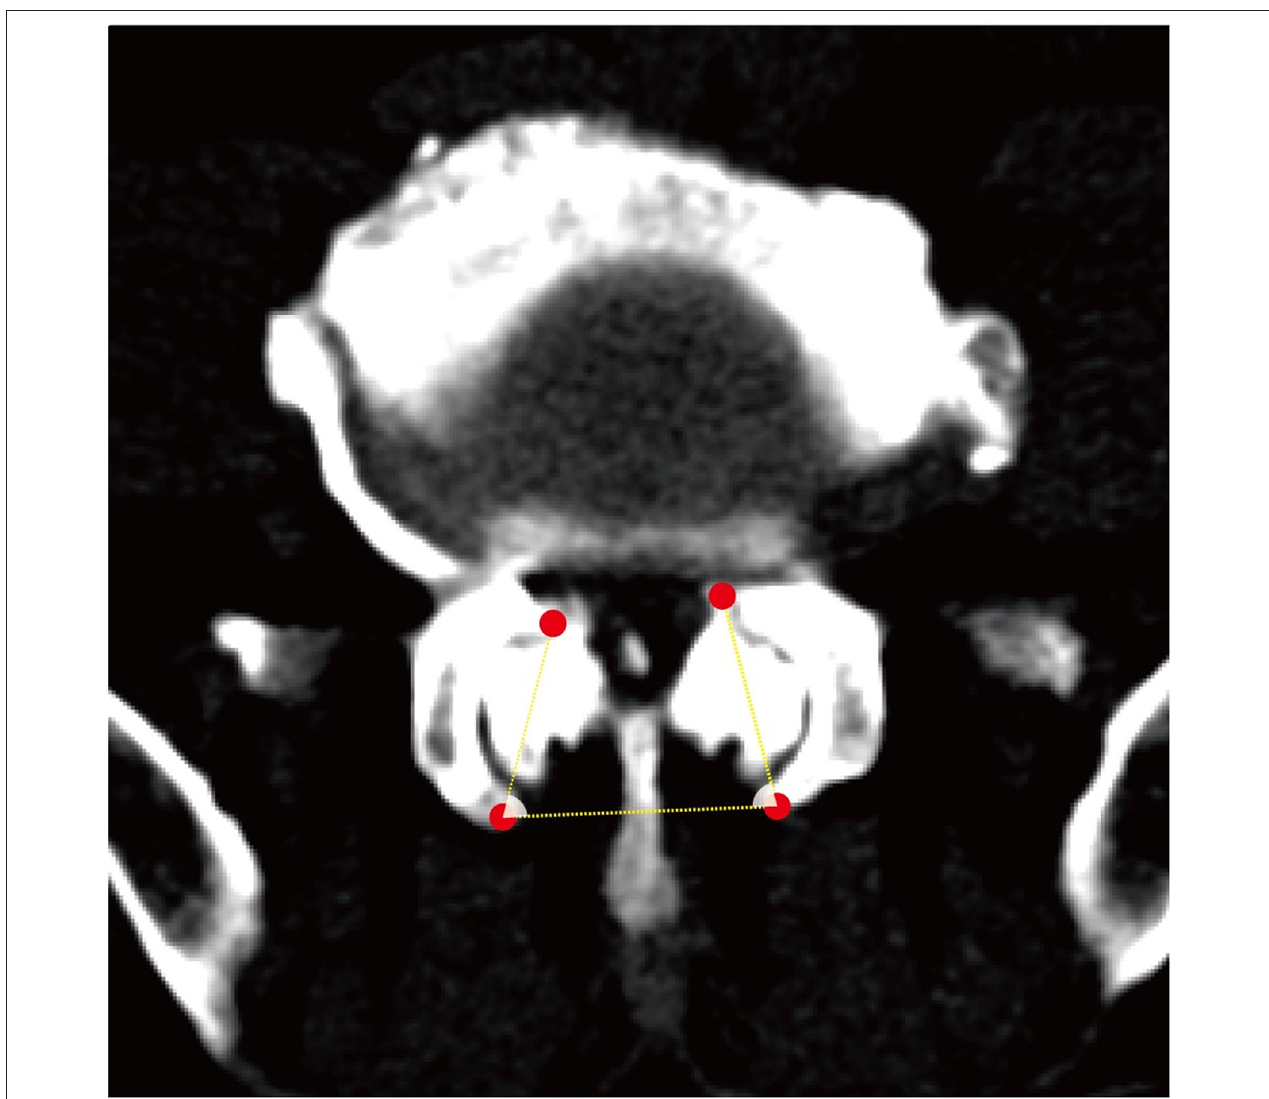
FIGURE 3 | A schematic diagram of the facet angle. A facet line was drawn between the 2 end points of each facet. The angle was measured between the facet line and the line connecting the bilateral dorsal points and recorded the average value.